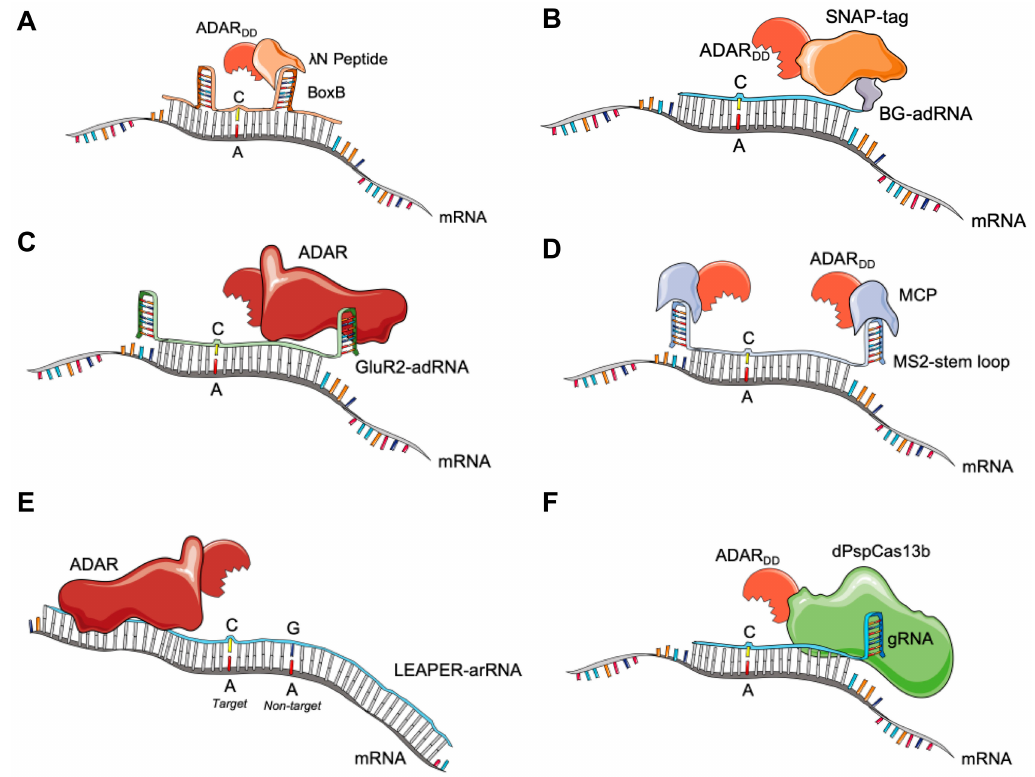
Figure 3. Schematic figures demonstrating the RNA editing approaches of ( A ) BoxB- λ N-ADAR with a dual BoxB design to recruit the λ N peptide ( B ) SNAP-tag-ADAR fusion with a O6-benzyl-guanine (BG) conjugated adRNA ( C ) Glu-adRNA approach where the GluR2 R / G hairpin recruits exogenous or endogenous full length ADAR ( D ) MS2-MCP-ADAR stem-loop approach with dual MS2